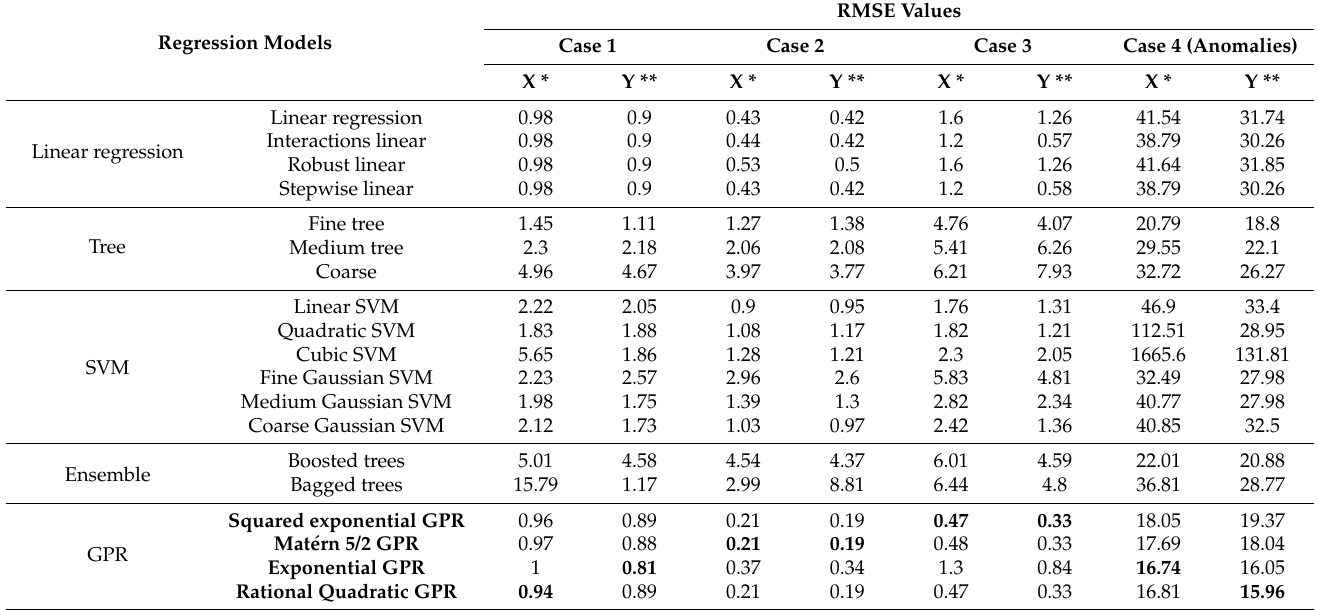
Table 5. Regression learning outcomes on the classified movement/interaction